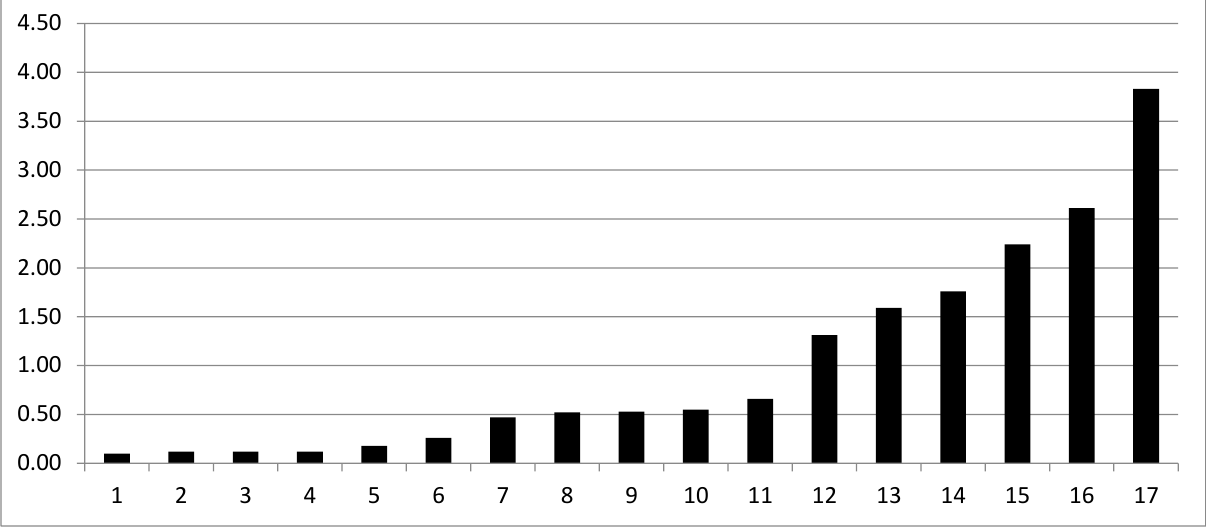
Figure 2. PSA drop for the 17 patients reporting any reduction in PSA. On the vertical axis, absolute values of PSA in ng/mL are reported.